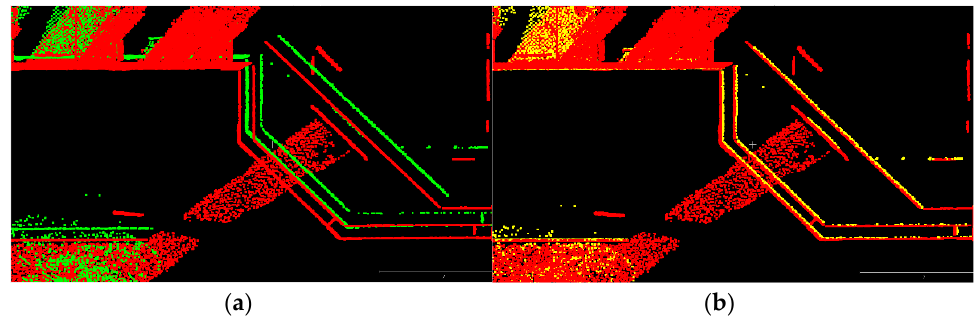
Figure 8. Example of point clouds before and after registration (Epson): ( a ) Top-view of the point clouds before ICP registration (static points in red and kinematic points in green); the translation vector length between the clouds is 1 m; ( b ) Top-view of point clouds after ICP registration (static points in red and transformed kinematic points in yellow); the RMSE from the registration was 0.02 m.